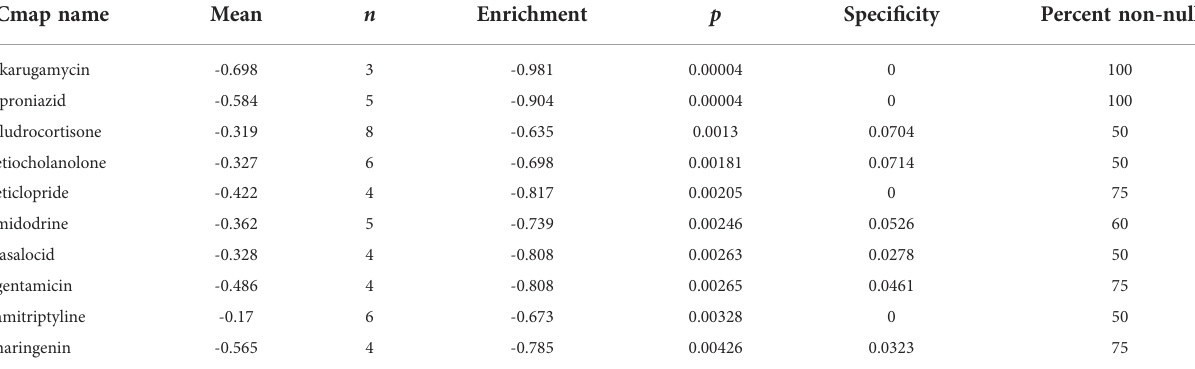
TABLE 1 Results of CMap analysis.